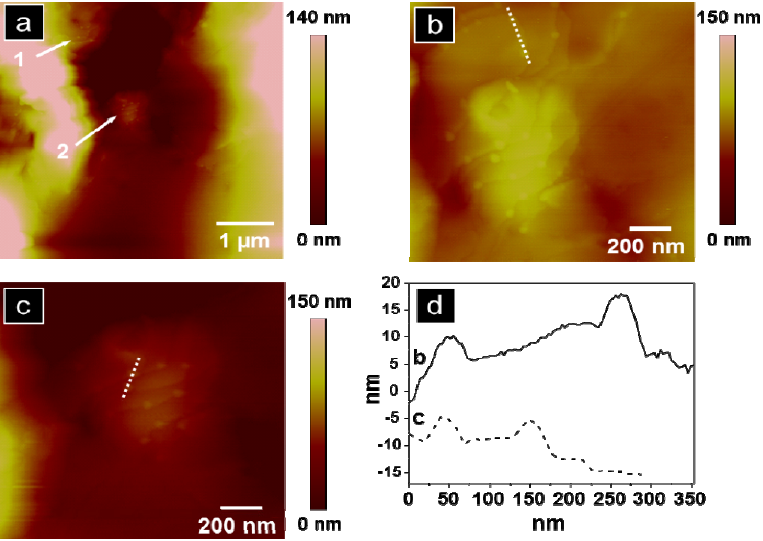
Figure 4. Topographic AFM images of the dorsal striatum from a rat treated with G4 biotinylated PAMAM dendrimers: ( a ) topography of brain capillary with two regions of interest marked; ( b ) zoomed-in analysis (1.4 × 1.4 µm) of region 1 from ( a ); ( c ) zoomed-in